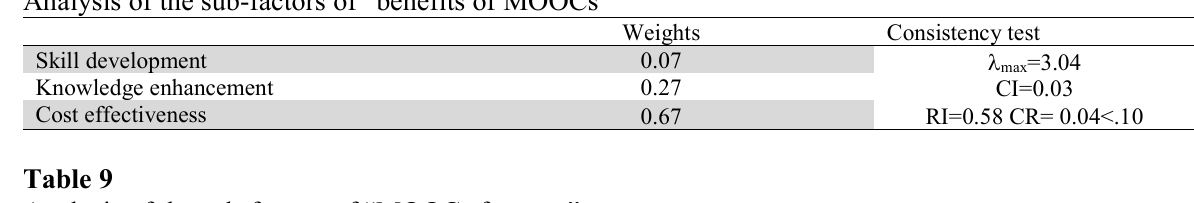
Analysis of the sub-factors of “benefits of MOOCs” Skill development